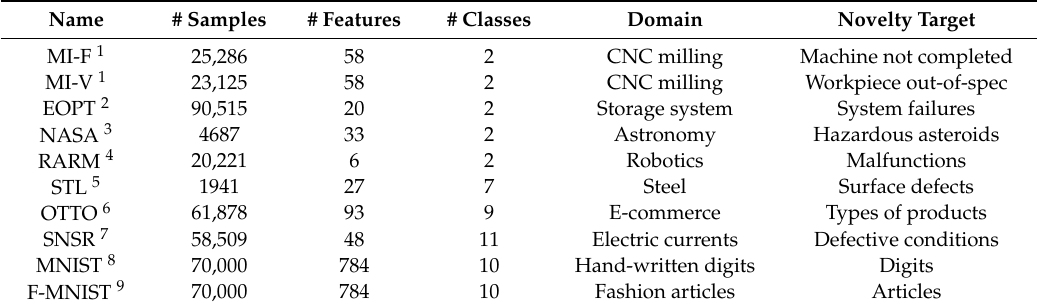
Table 1. Description of novelty datasets and benchmark